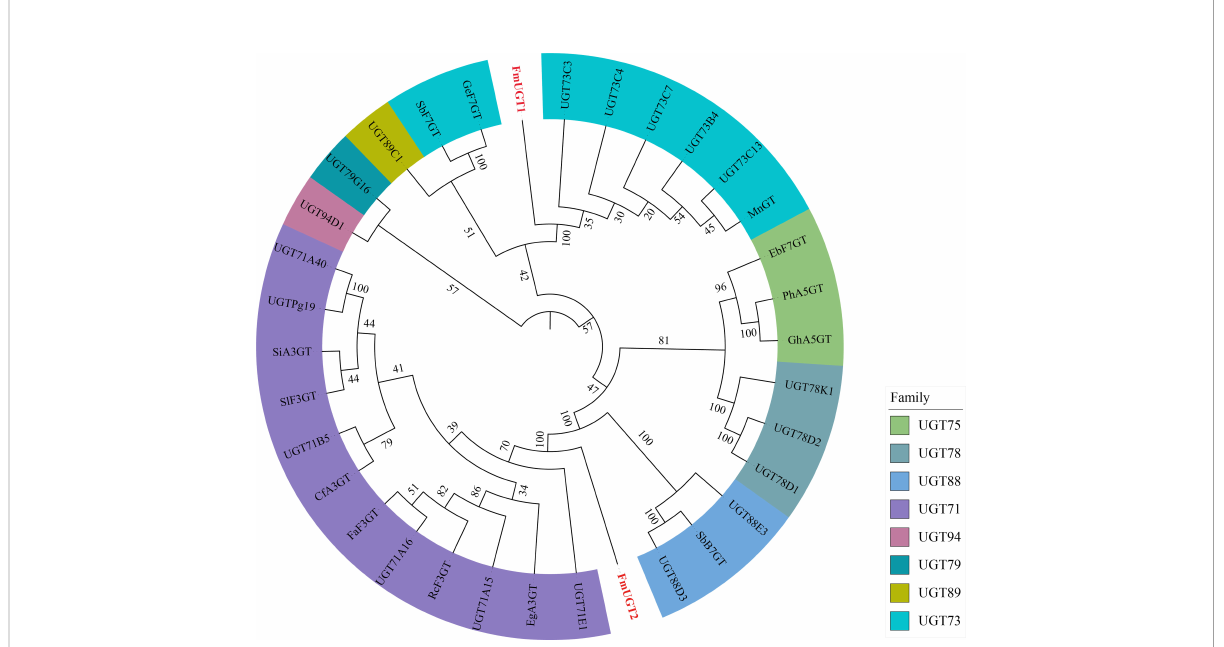
FIGURE 2 Phylogenetic analysis of FmUGT1 and FmUGT2 with other UGTs. FmUGTs from this study were colored in red. The GenBank accession numbers of UGT proteins in the tree are in Supplementary Table